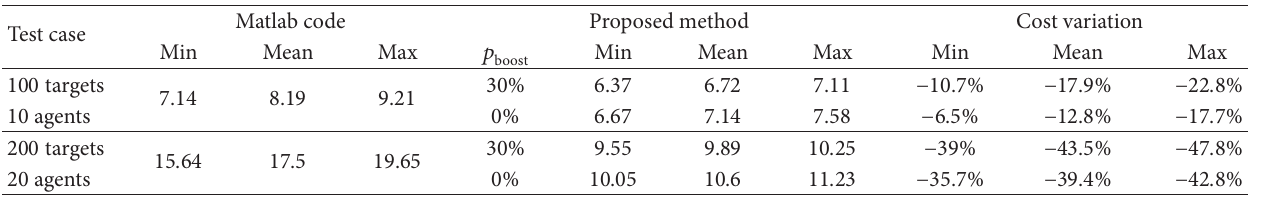
Table 4: Comparison between the proposed GAID method and a Matlab MTSP code. For each test, 𝑘 method is used. Targets are randomly generated over the unit square.